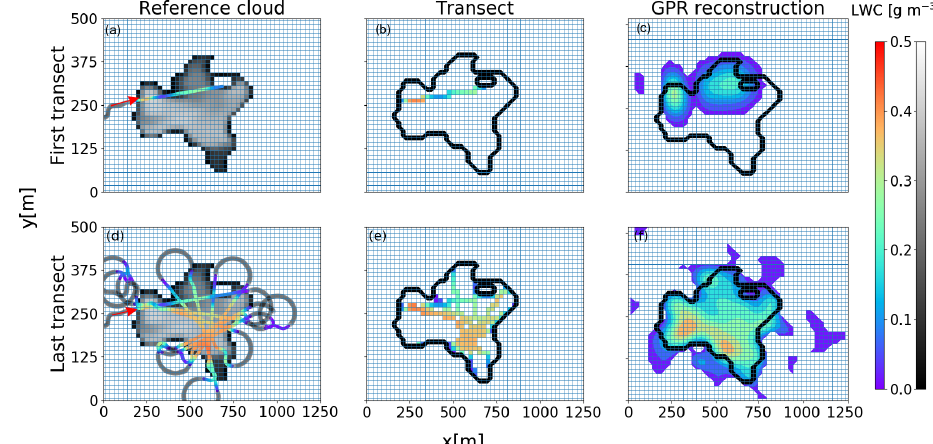
Figure 7. (a) Cross section of simulated cloud N2 at 150m above cloud base in gray with the transect of the RPA; the color represents the LWC measured. (b) Reconstructed LWC in the cross section based on RPA transects. (c) Reconstructed LWC in the cross section with GPR mapping with λ x = 75m. The first row corresponds to the end of the first transect, and the second row corresponds to all transects at the end of the exploration. The red arrow represents the first entrance in cloud N2 starting the rosette pattern (Sect. 2.2).